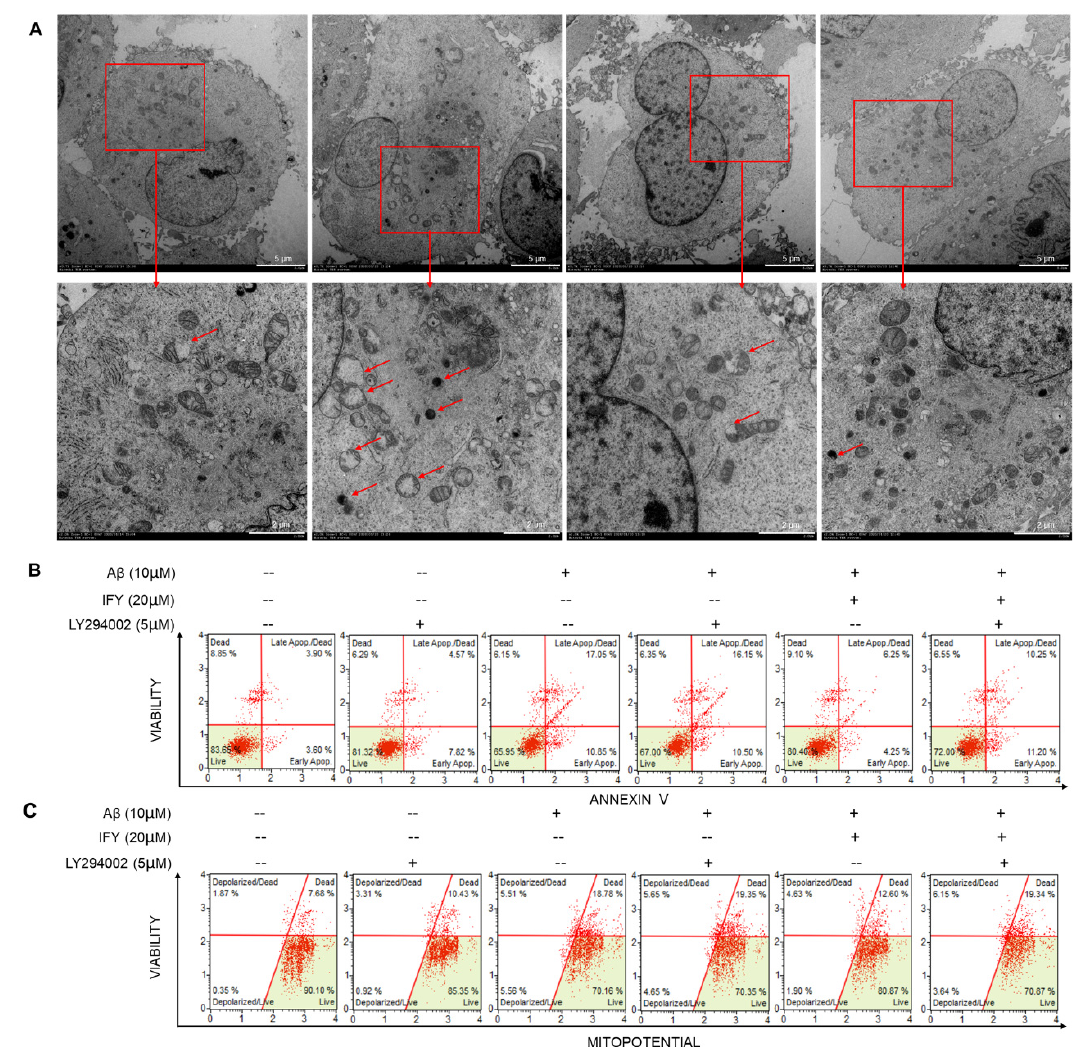
Figure 6. IFY resisted the mitochondrial-related apoptosis in U251 cells induced by A β 1-42 which could be blocked by LY294002. ( A ) IFY improved the mitochondrial swelling, crest rupture and increased the electron density caused by A β 1-42 in U251 cells observed by transmission electron microscopy (TEM (magnification × 0.7 k, scale bar: 5.0 μ m [magnification × 2.0 k, scale bar: 2.0 μ m] where n = 3)).